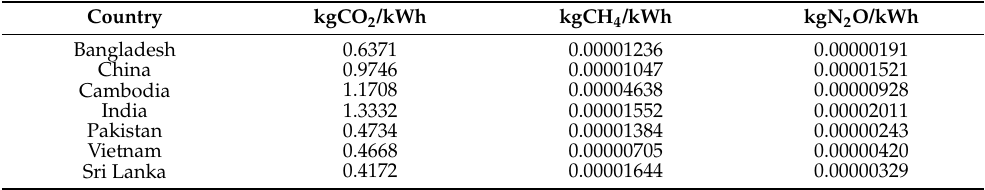
Table 2. Country-wise emissions per kWh of electricity generated [20].